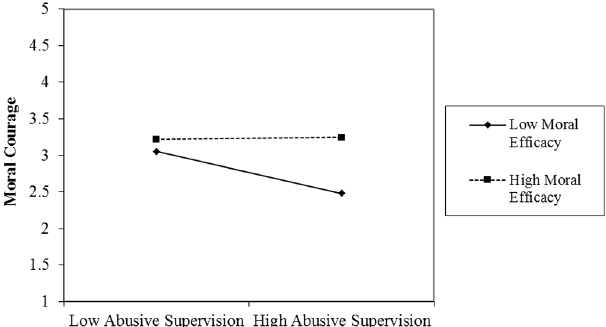
Figure 2. The moderating role of moral ef fi cacy on the relationship between abusive supervision and moral